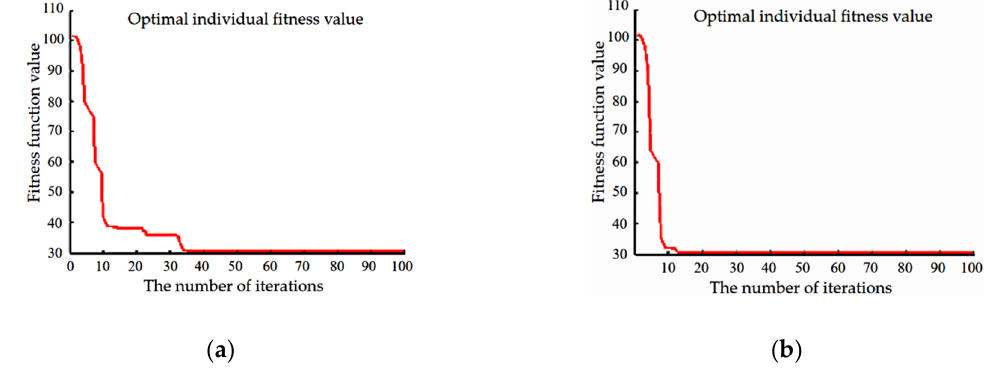
Figure 5. Comparison and analysis curve of fitness function value. ( a ) PSO curve, ( b ) GA-PSO curve.